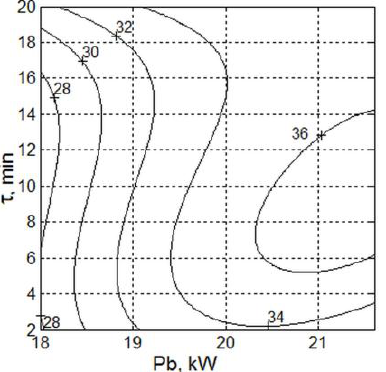
Figure 7. Contour plot of the molten pool diameter d 2 depending on the beam power P b and the melting time τ .